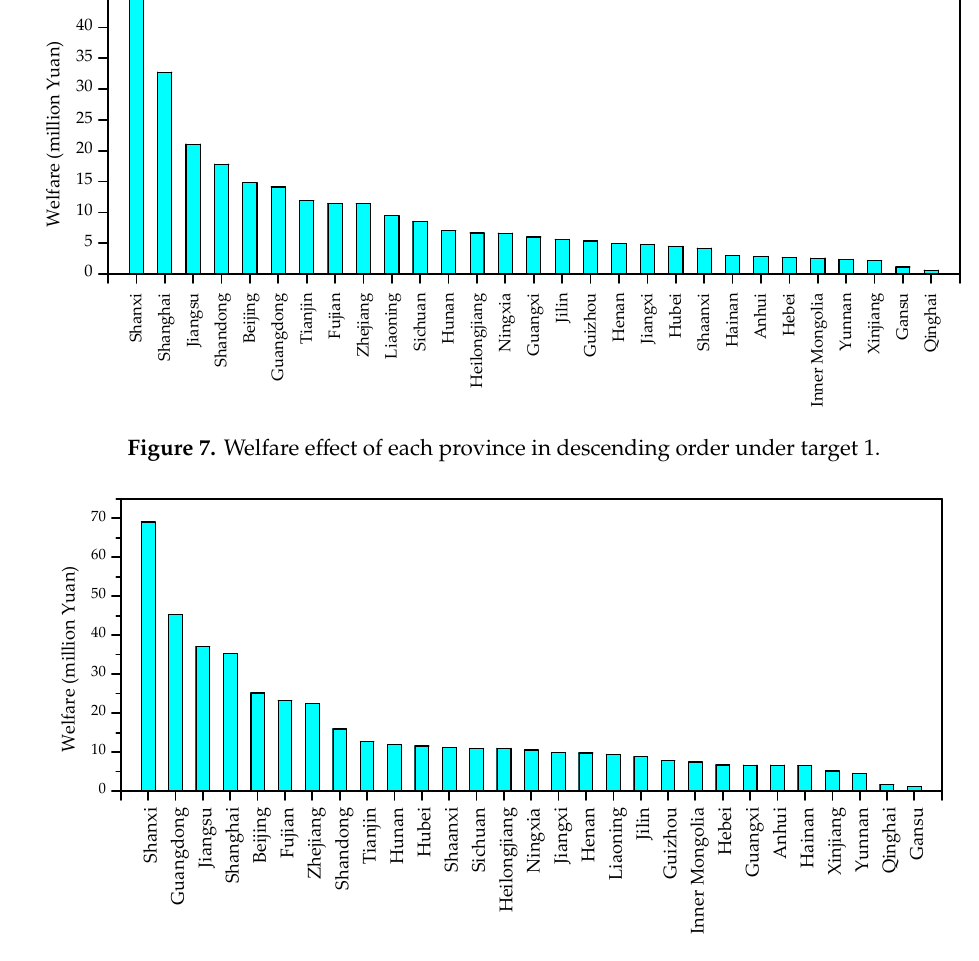
Figure 8. Welfare e ff ect of each province in descending order under target Figure 8. Welfare effect of each province in descending order under target 2. Figure 8. Welfare effect of each province in descending order under target 2.